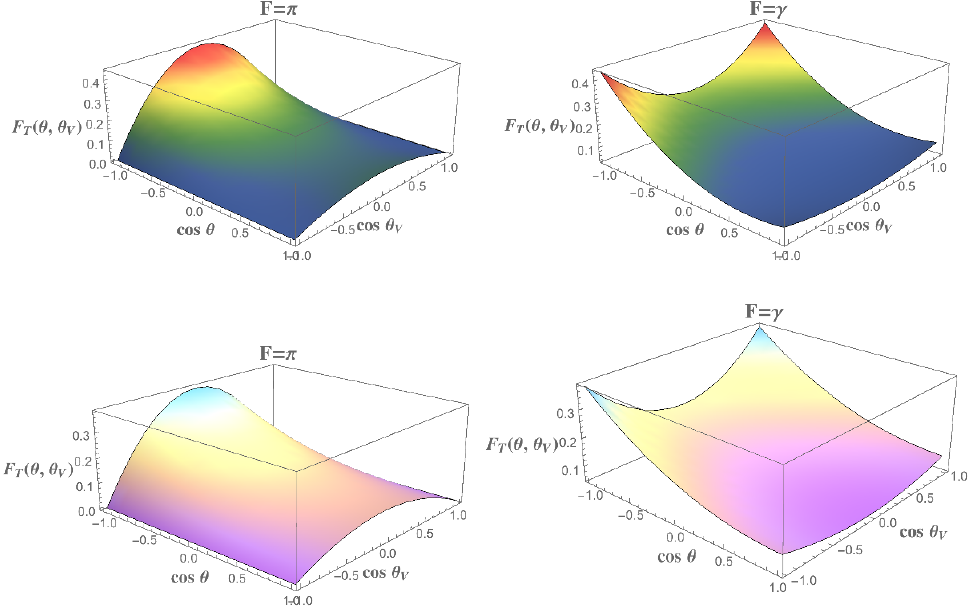
JHEP06(2018)082